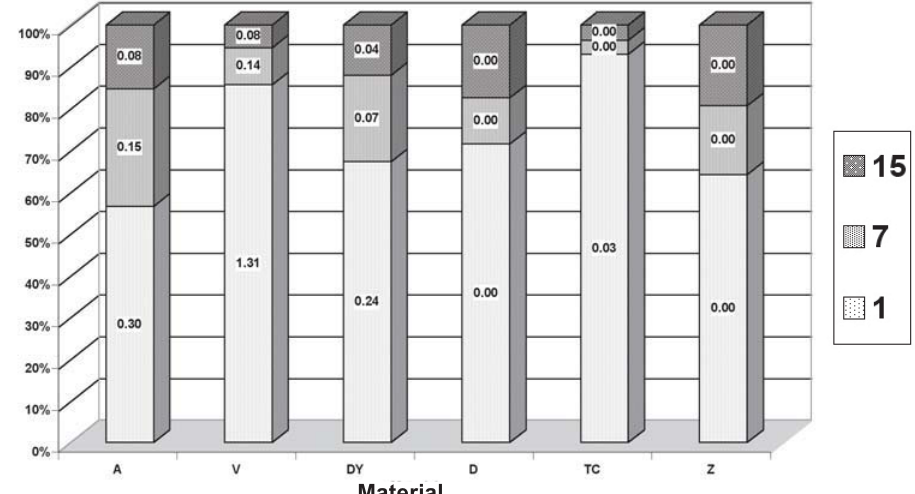
FIGURE 3- Distribution of the total fluoride release in CpH on the 1 st , 7 th and 15 th days (A= Ariston pHc; V= Vitremer TM ; DY=Dyract AP; D=Definite ® ; TC=Tetric ® Ceram;